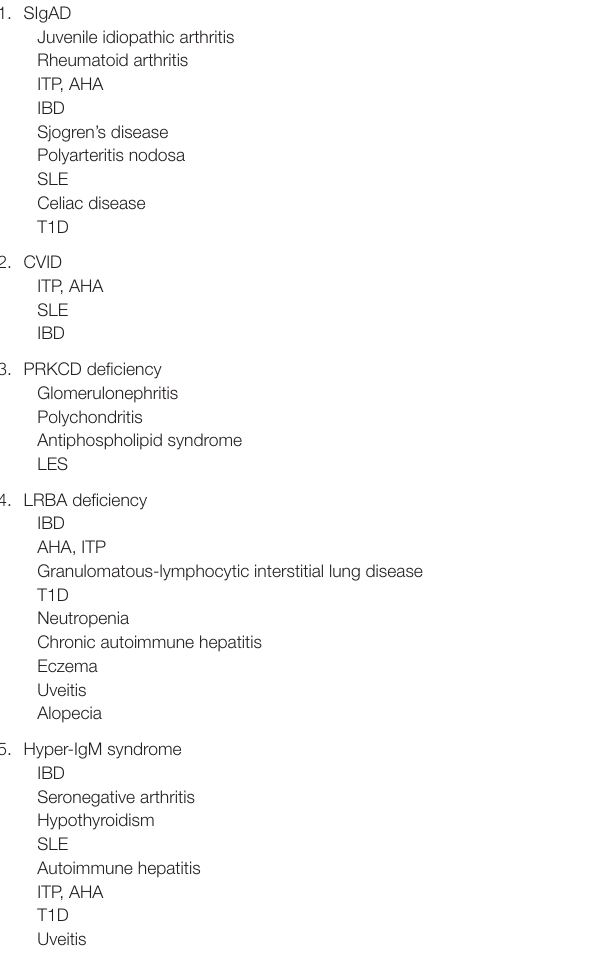
TABLe 1 | Autoimmune manifestations in humoral immunodeficiencies.